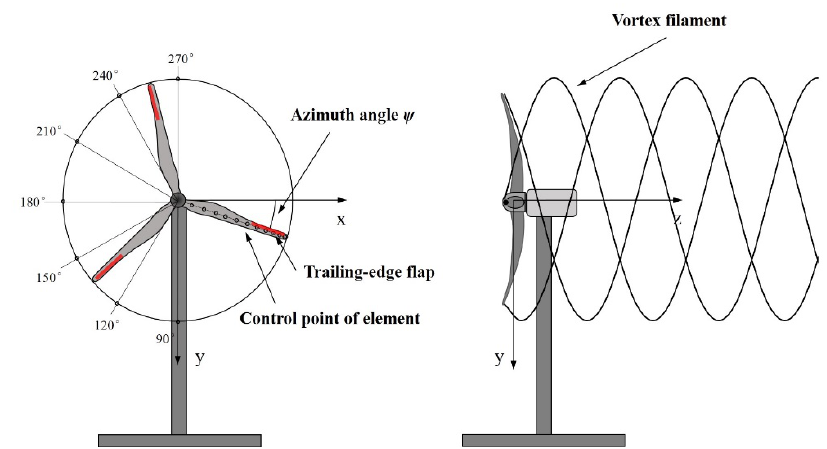
Figure 1. Wind turbine model with trailing-edge flap used in the free vortex wake (FVW) method.